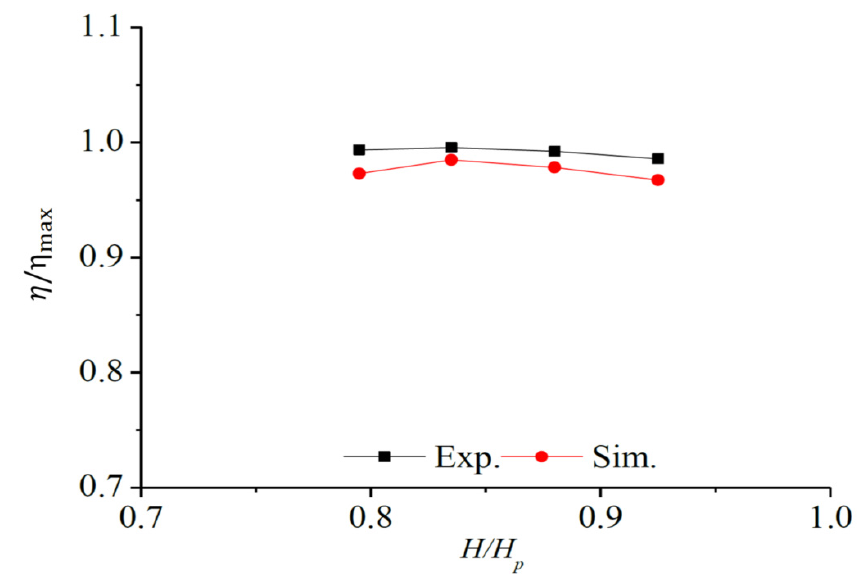
Figure 4. Comparison of numerical simulation and experimental results [26]. Table 1. Element numbers of the finite volume mesh for each sub-domain. Table 1. Element numbers of the finite volume mesh for each